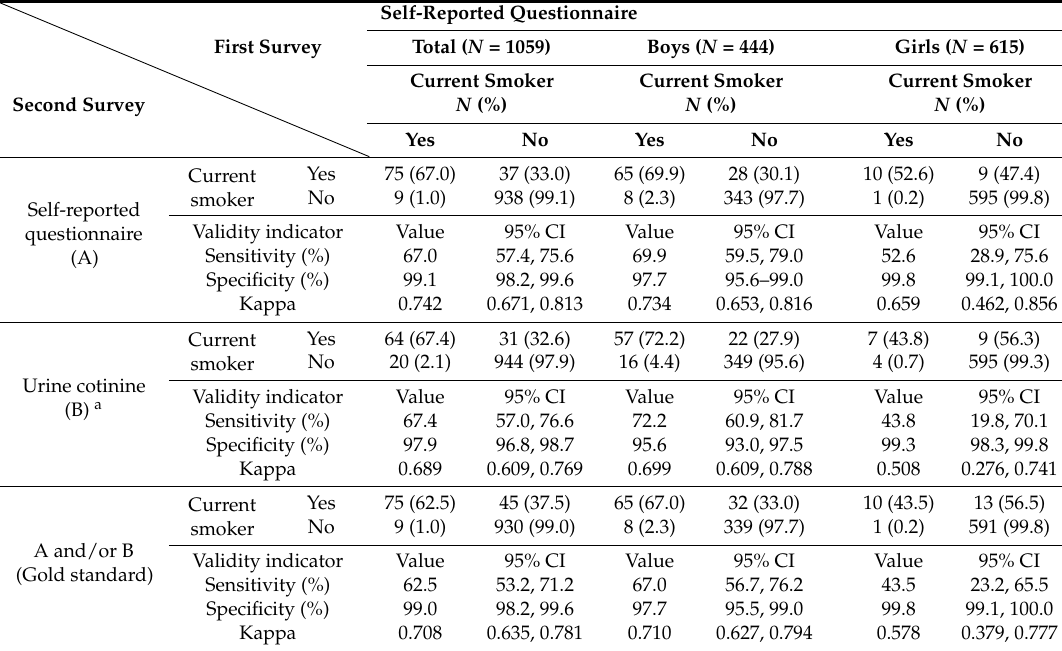
Table 3. Validity evaluation of self-reported current cigarette smoking prevalence between the first and second